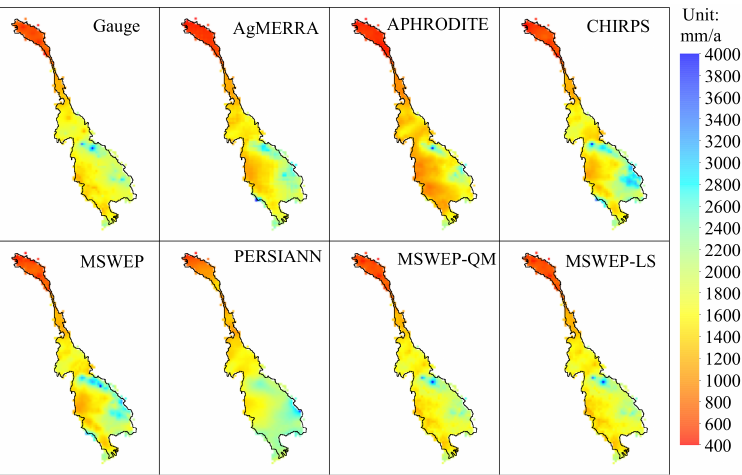
Figure 8. Spatial patterns of annual average precipitation derived from gauge observation, AgMERRA, APHRODITE, CHIRPS, MSWEP, PERSIANN, MSWEP-QM, and MSWEP-LS from 1998 to